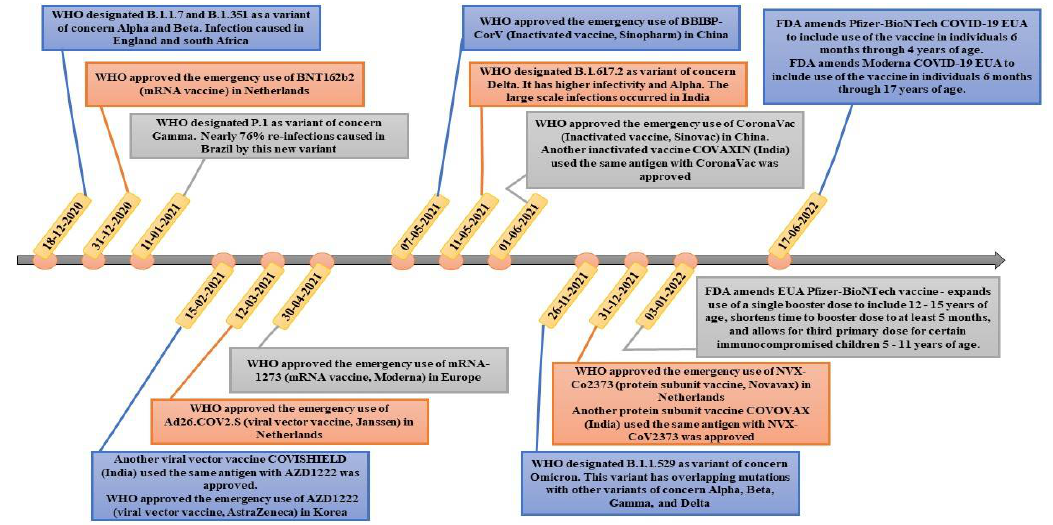
Figure 3. A chronology of significant events in the development of COVID-19 vaccines. The Emergency Use Authorization (EUA) of BNT162b2 happened shortly after the appearance of alpha and beta variants in the UK in December 2020. The WHO granted EUA for the adenovirus vector-based vaccine AZD1222, the inactivated vaccines by Sinopharm and Sinovac, and the protein subunit vaccine NVX-Co2373 in 2021. The FDA approved the use of the mRNA-1273 vaccine in children and adolescents from 6 months to 17 years of age in